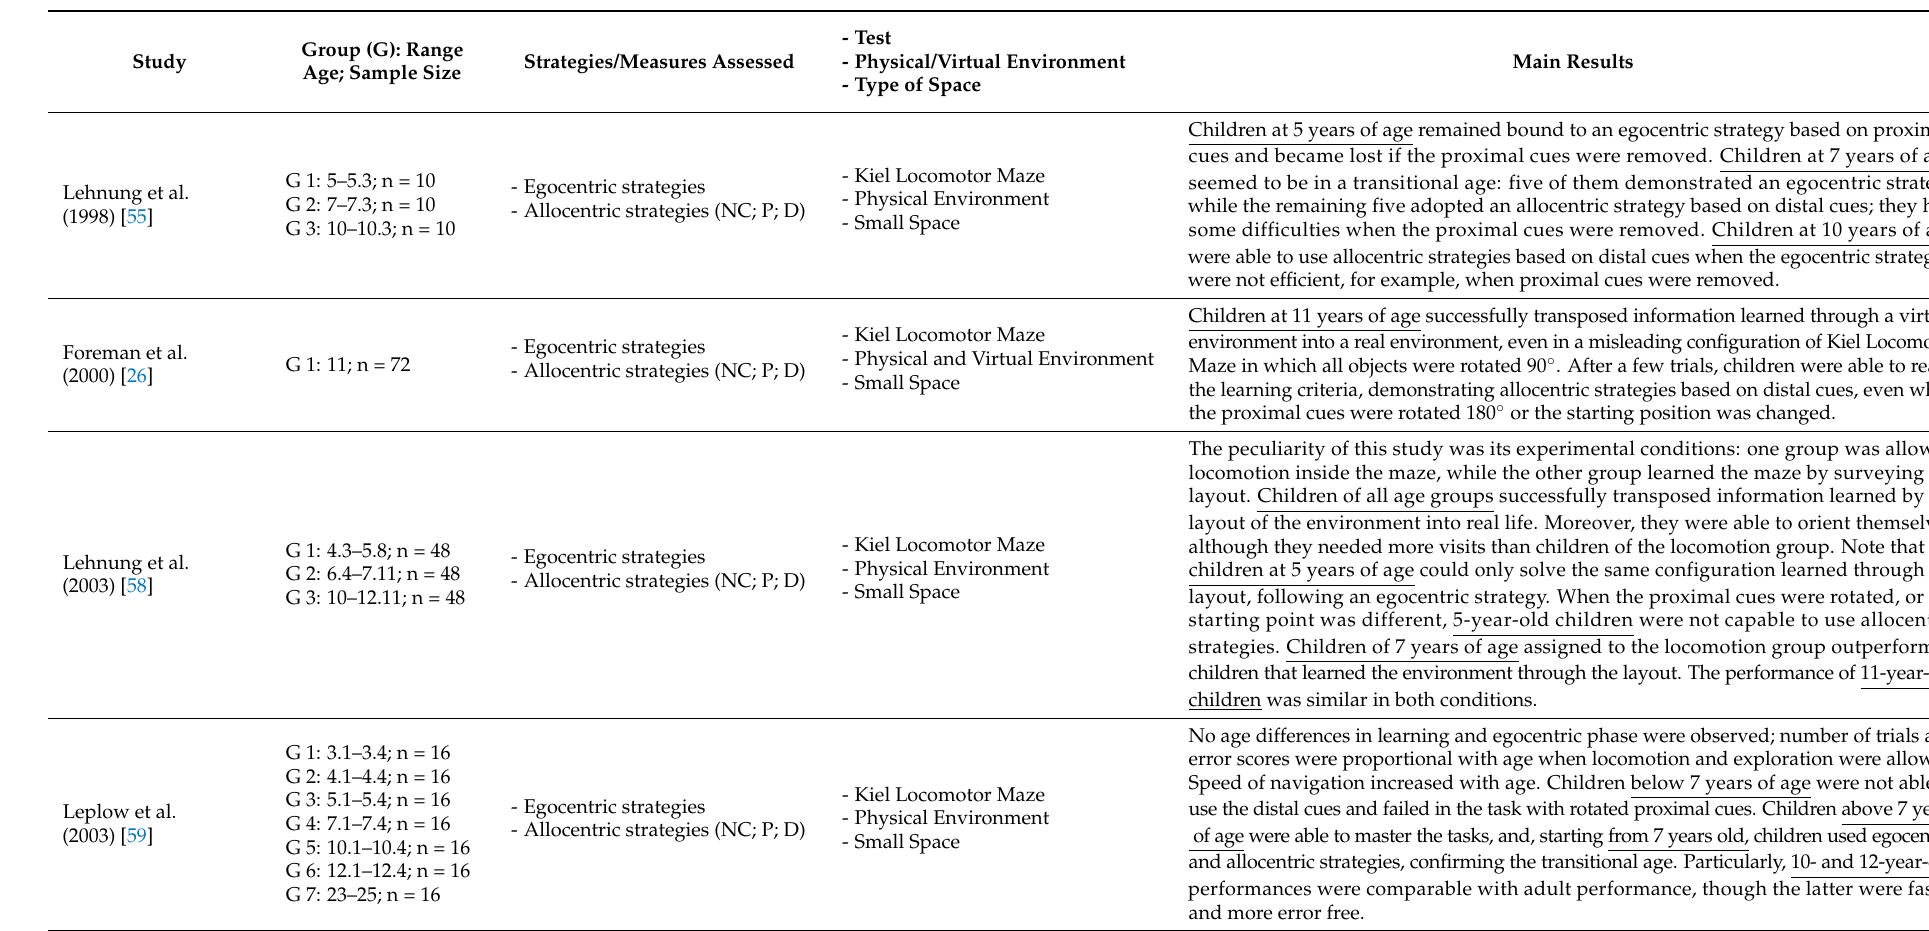
Table 1. Characteristics of studies on spatial abilities in middle